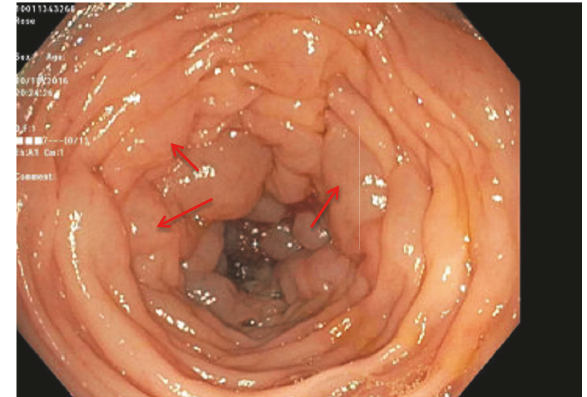
Figure 4: Pneumatosis coli of the descending colon (arrows).